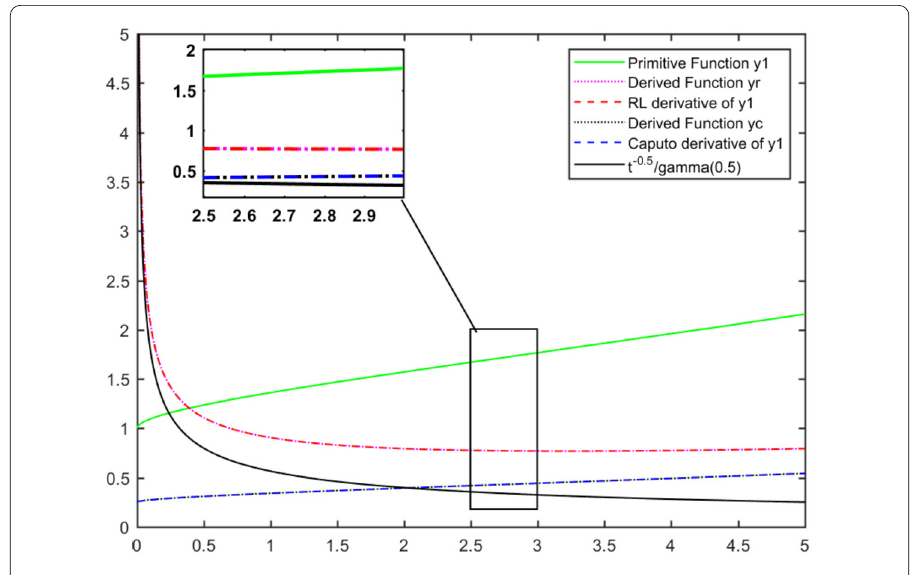
Figure 1 The fractional derivatives of the generalized MLFs for β = 1